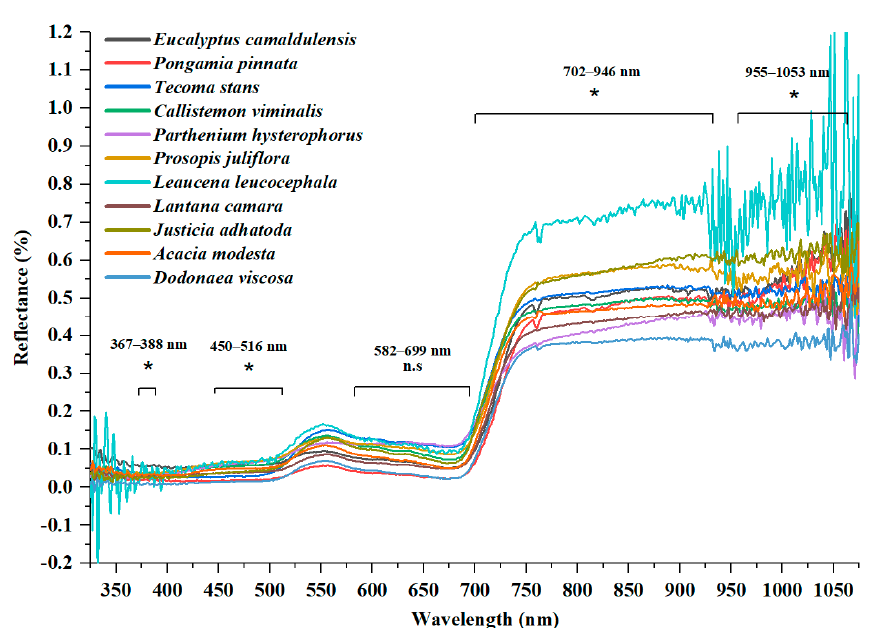
Figure 9. Graphical representation of discriminating wavebands ( p < 0.05) among plant species through ANOVA in different regions of spectrum.